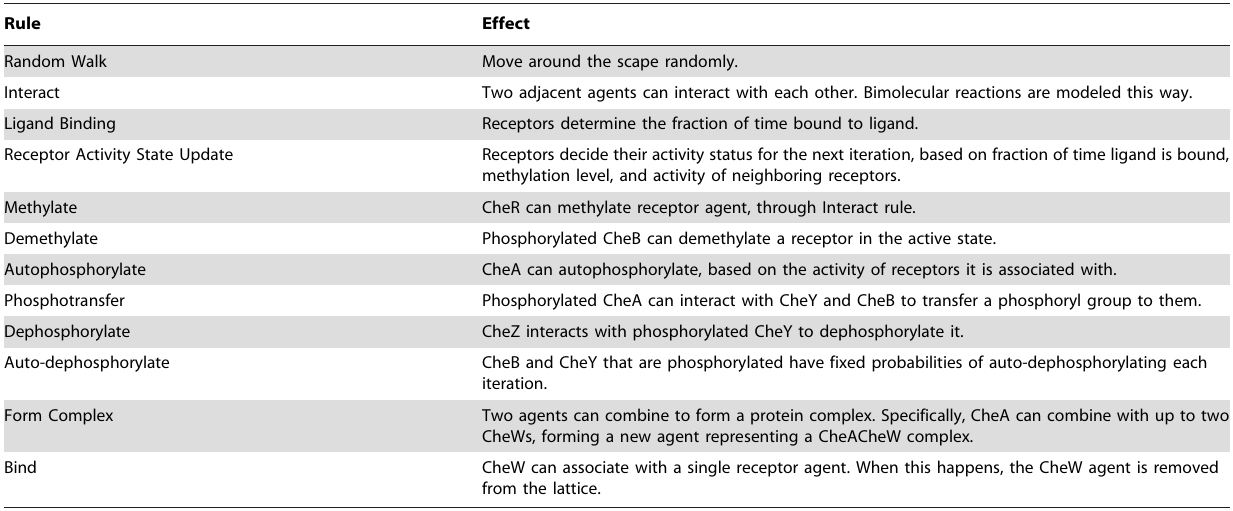
Table 2. Chemoscape rules and their effects.